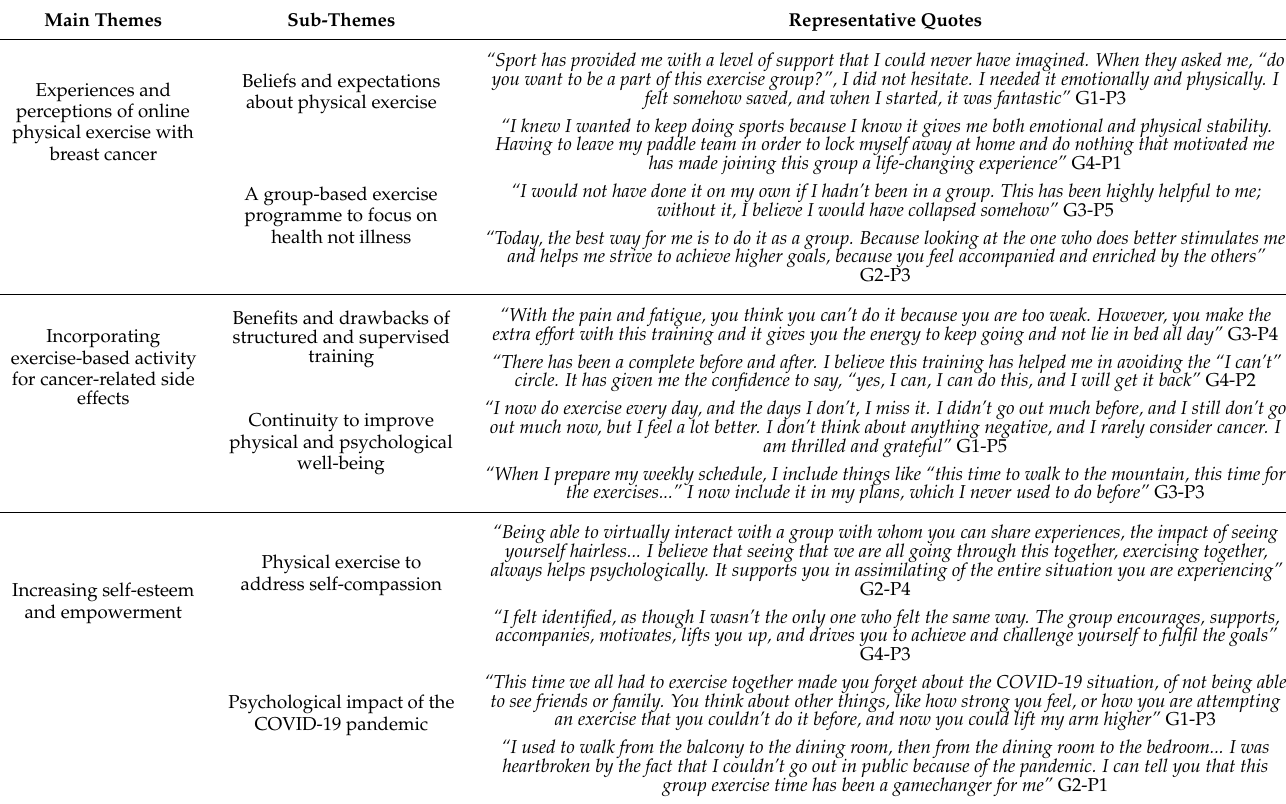
Table 1. Themes, sub-themes, and representative